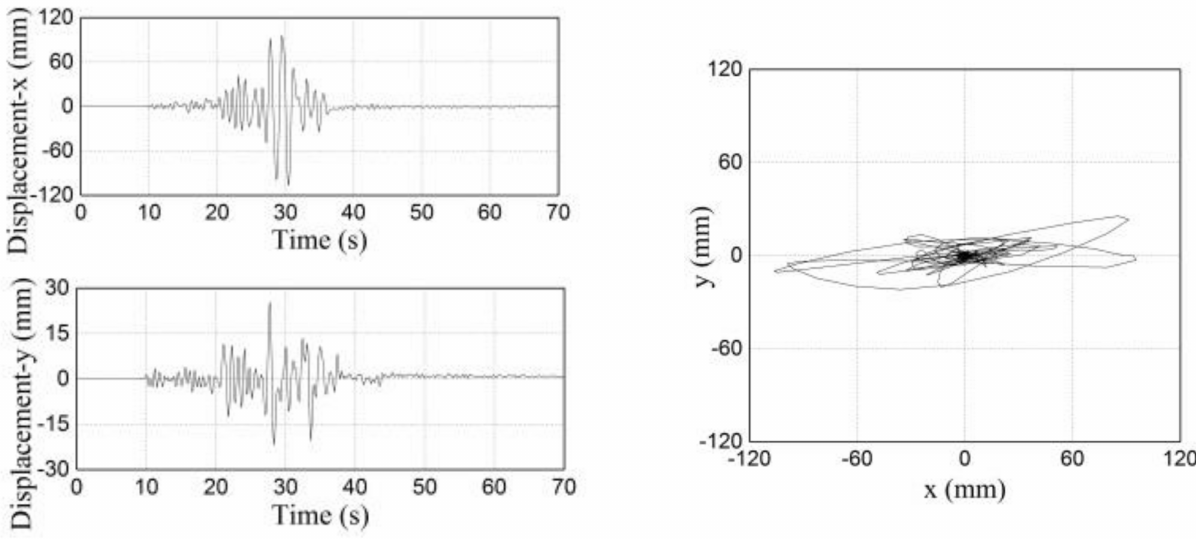
Figure 30. The relative displacements and movement locus of the b200d380 bearing subjected to ChiChi-TCU084 (intermediate-frequency) ground motion when PGA = 2 m/s 2